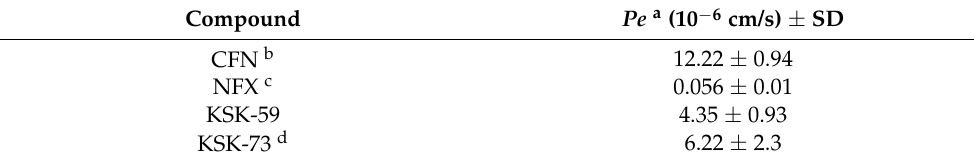
Table 2. The results obtained in PAMPA.